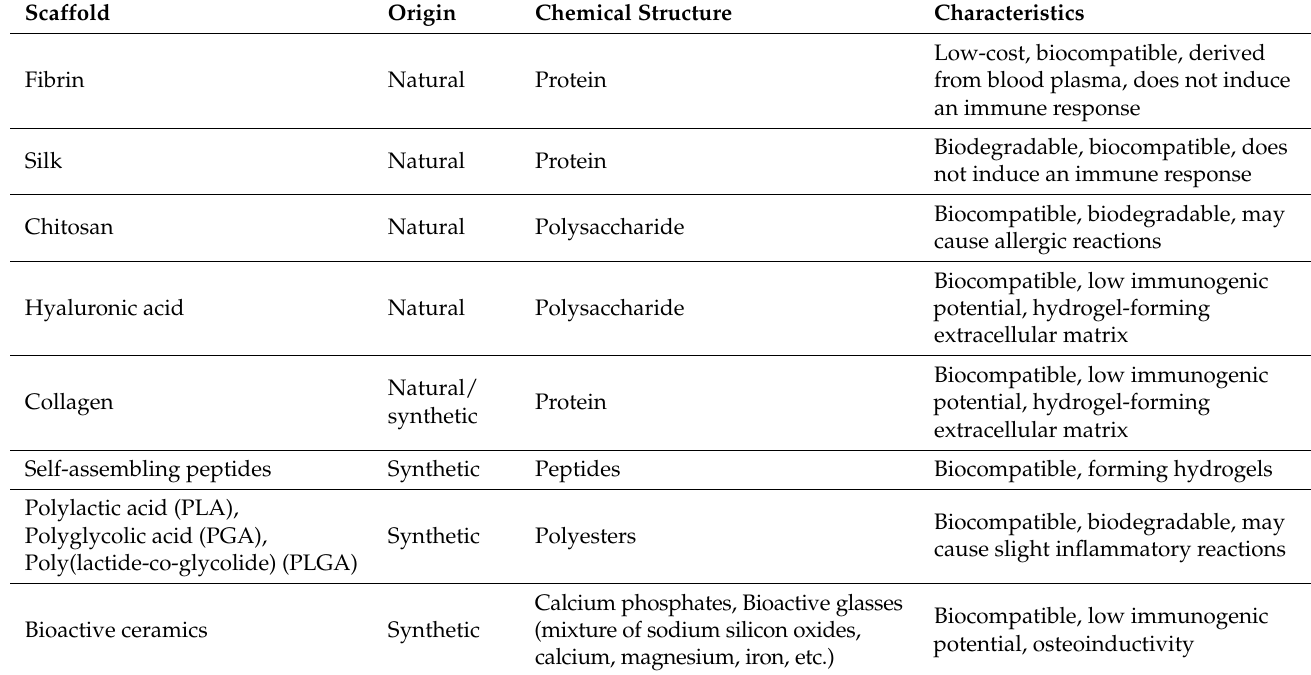
Table 3. Selected substances proposed as scaffolds in regenerative